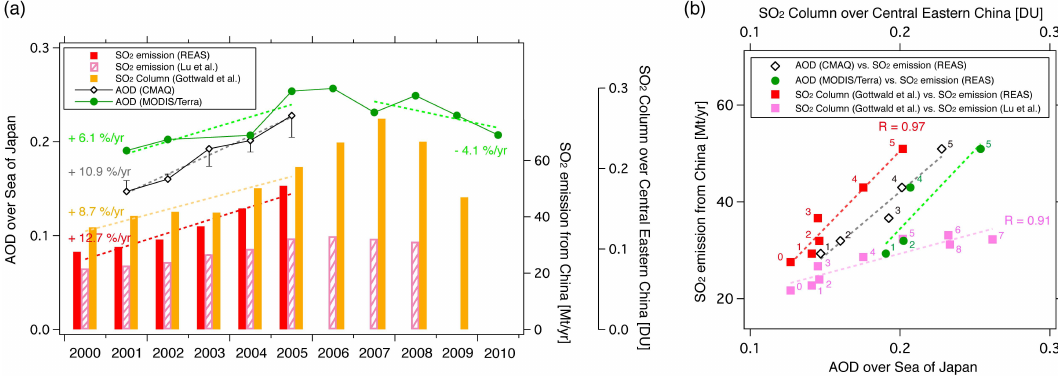
Fig. 4. (a) Temporal plots of the annual mean AODf over the Sea of Japan (region 3 in Fig. 1) by CMAQ (black line with diamonds) and MODIS/Terra (green line with circles), SO 2 emissions from China based on the REAS emissions inventory (red bars) and Lu et al. (pink bars), and SO 2 VCD over Central Eastern China using GOME/SCIAMACHY (orange bars, from Gottwald and Bovensmann, 2011). Error bars with black lines represent the annual mean AOD f over the Sea of Japan from the CMAQ sensitivity case study (“EyyM 00 ”). (b) Scatterplots of (bottom-left axis) AODf from CMAQ (black diamonds) and AODf from MODIS/Terra (green circles) against the SO 2 emissions from China based on REAS, (top-left axis) SO 2 VCD from GOME/SCIAMACHY with the SO 2 emissions from REAS (red squares), and Lu et al. (pink squares). The numbers near each graph indicate the year (i.e. 5 means the year